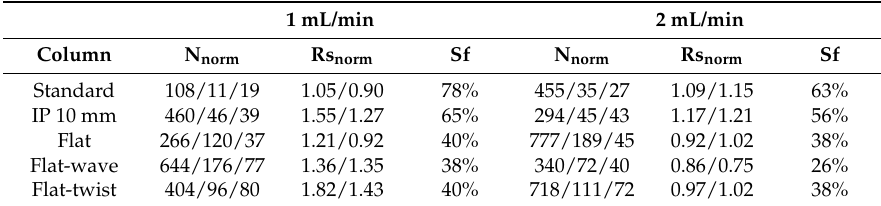
Figure 2. Set of high-speed countercurrent chromatography (HSCCC) chromatograms for protein separation using standard and four modified tubings. Experimental conditions: Apparatus was s type-J coil planet centrifuge with 10 cm revolution radius; the column was a spiral tube assembly with four interwoven spiral tubes containing standard and four processed tubing. The volume for each column is as follows. Standard: 60 mL; IP 10: 52 mL; flat: 45 mL; flat-wave: 45 mL; and flat-twist: 38 mL. Solvent system: polymer phase system composed of PEG 1000 and dibasic potassium phosphate, each 12.5% ( w/w ) in deionized water. Sample: cytochrome c (1 mg) (peak I), myoglobin (10 mg) (peak II), and lysozyme (10 mg) (peak III) in 1 mL of upper phase; flow rate: 1–2 mL/min. Mobile phase: upper phase; elution mode; tail-to-head elution; revolution speed: 800 rpm; detection: 280 nm. Stationary phase retention: see Table 1. IP 10 mm indicates intermittently pressed at 10 mm interval in 10 mm width. Partition efficiencies of standard and four modified columns by normalizing in column